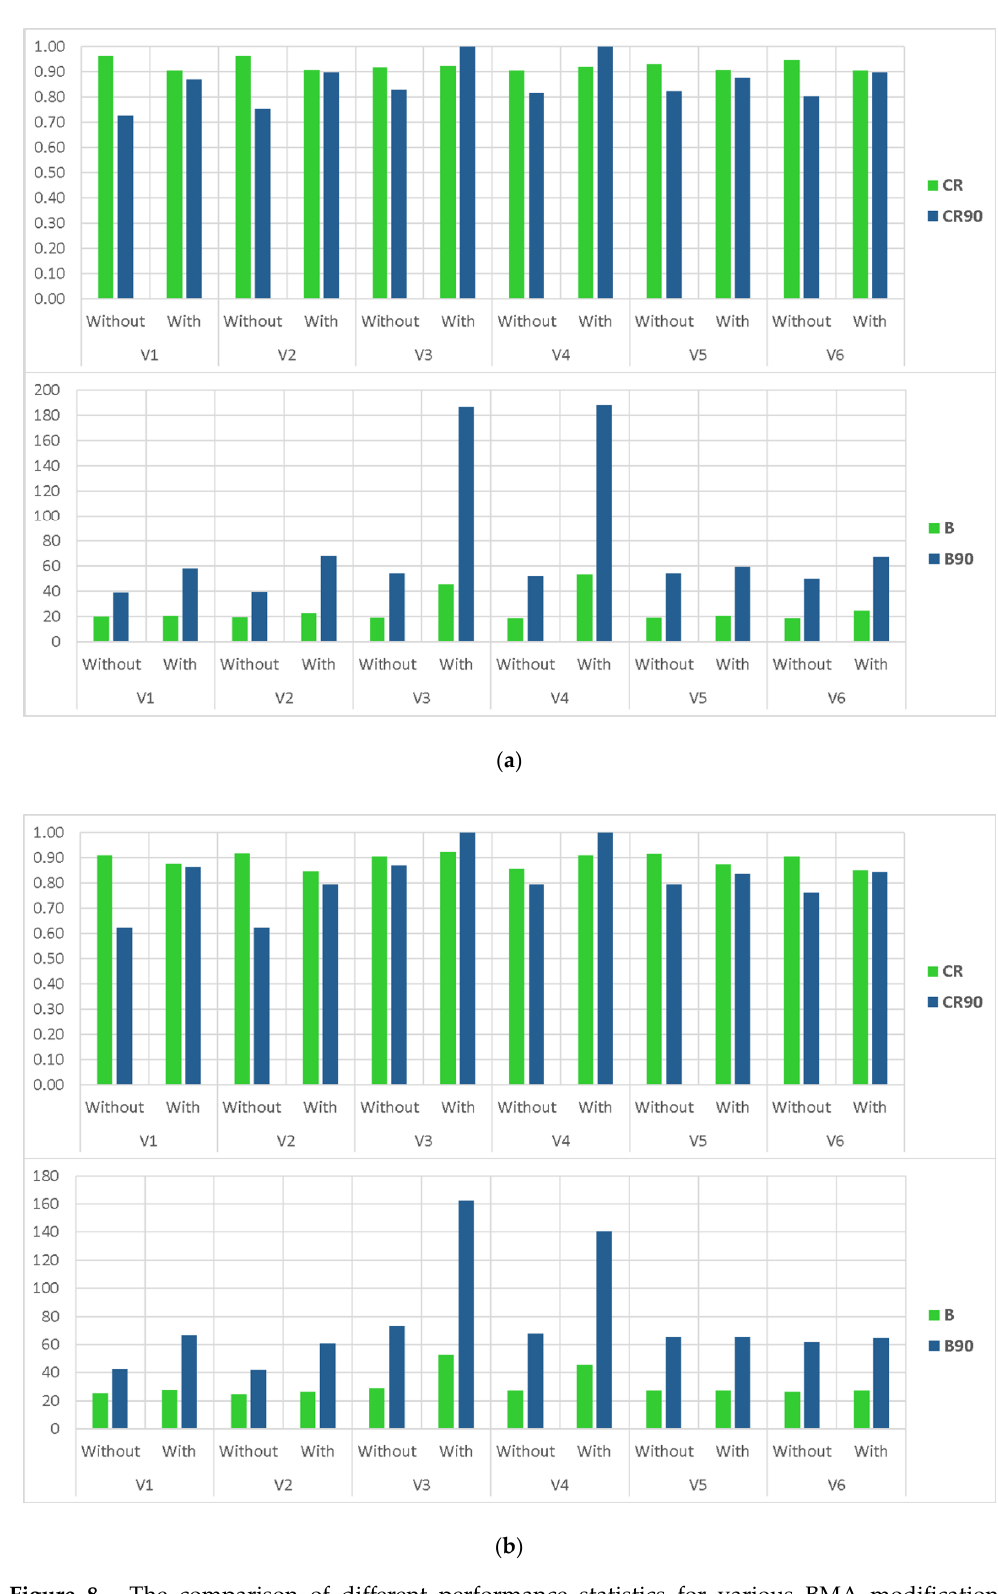
Figure 8. The comparison of di ff erent performance statistics for various BMA modifications generated by considering di ff erent standard deviation types and non-implementation (“Without”) and implementation (“With”) of their corresponding best data transformation method for the validation period in the ( a ) Big East River and ( b ) Black River